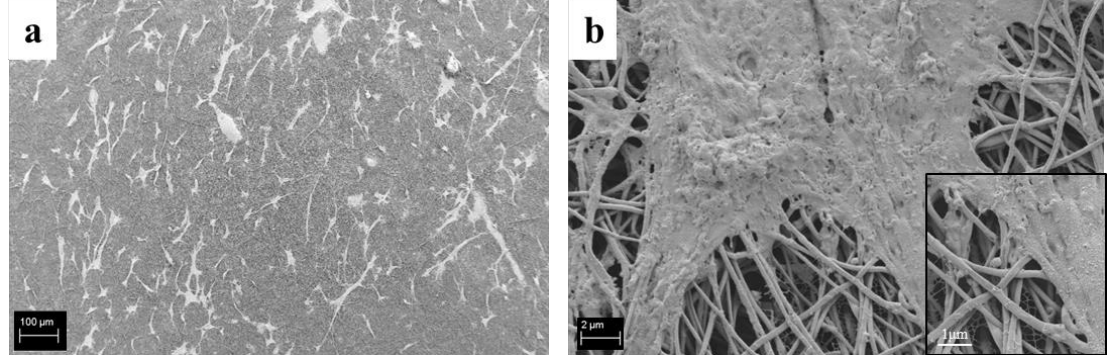
Figure 12. SEM micrographs of ST-2 cells seeded onto PCL_Ca_MCM-41 composite electrospun mats at different magnifications: 20 0× ( a ) and 10,000 × ( b ).